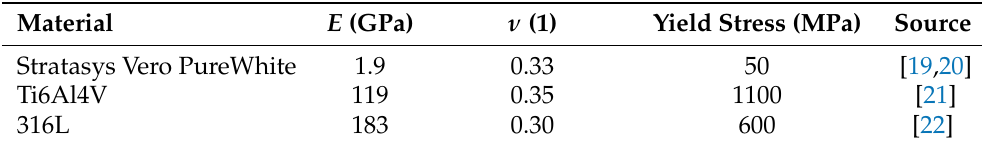
Table 1. Young’s modulus ( E ) and Poisson’s ratio ( ν ) of tested materials. Material E (GPa) ν (1) Yield Stress (MPa) Source Stratasys Vero PureWhite 1.9 0.33 [19,20] Ti6Al4V 119 0.35 316L 183